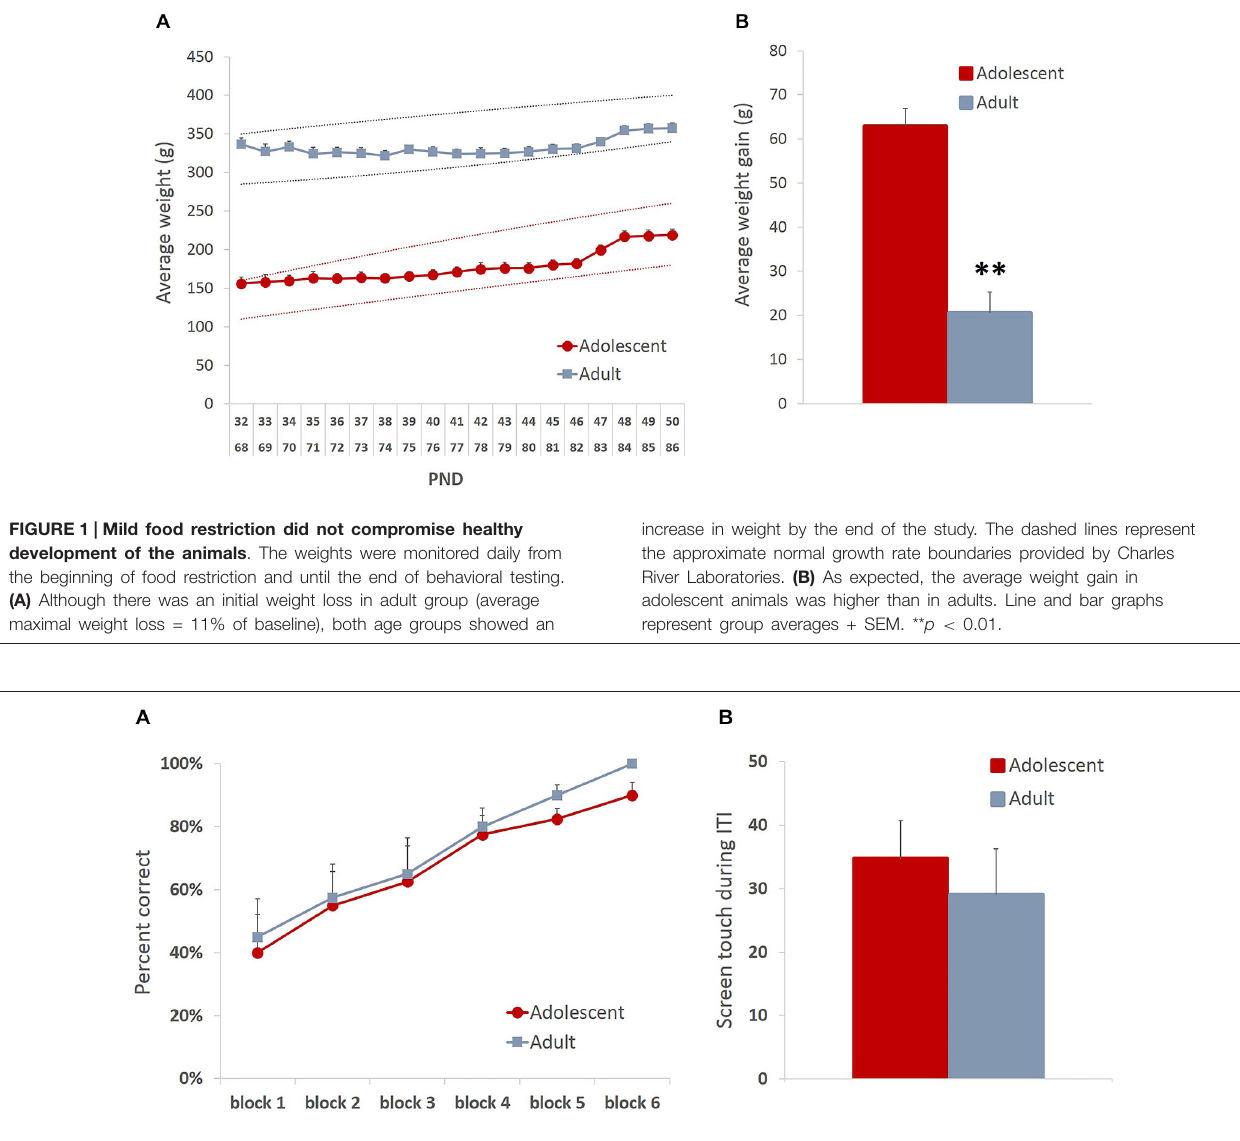
animals improved their performance within session with no differences between age groups (B) Adolescent and adult animals learned the contingency of reward on the stimuli, demonstrating low levels of nose-poking the screen during the ITI with no group differences. Line and bar graphs represent group averages + SEM.